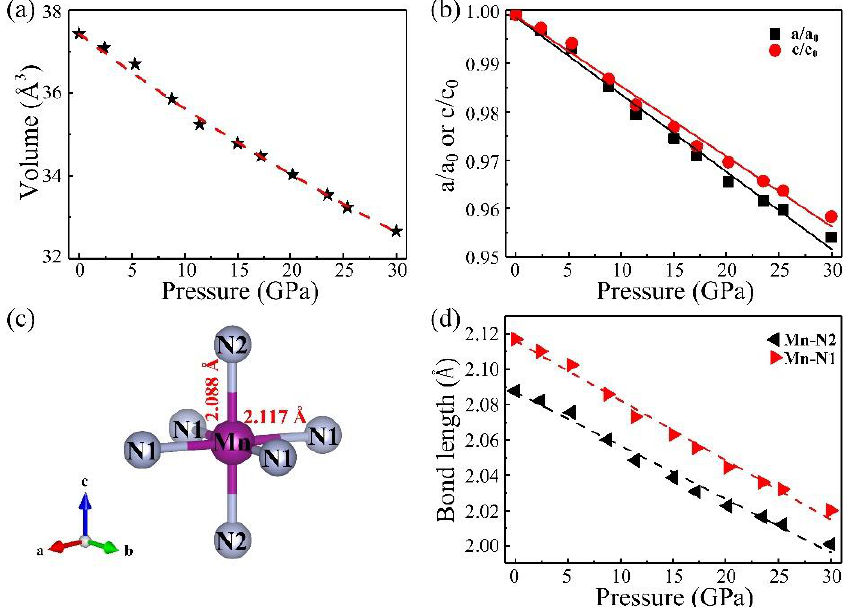
Figure 3. The changes of ( a ) unit cell volume and ( b ) lattice parameters in the entire pressure change; ( c ) The atomic arrangement of the MnN 6 octahedron; ( d ) Bond length of Mn–N as a function of pressure.